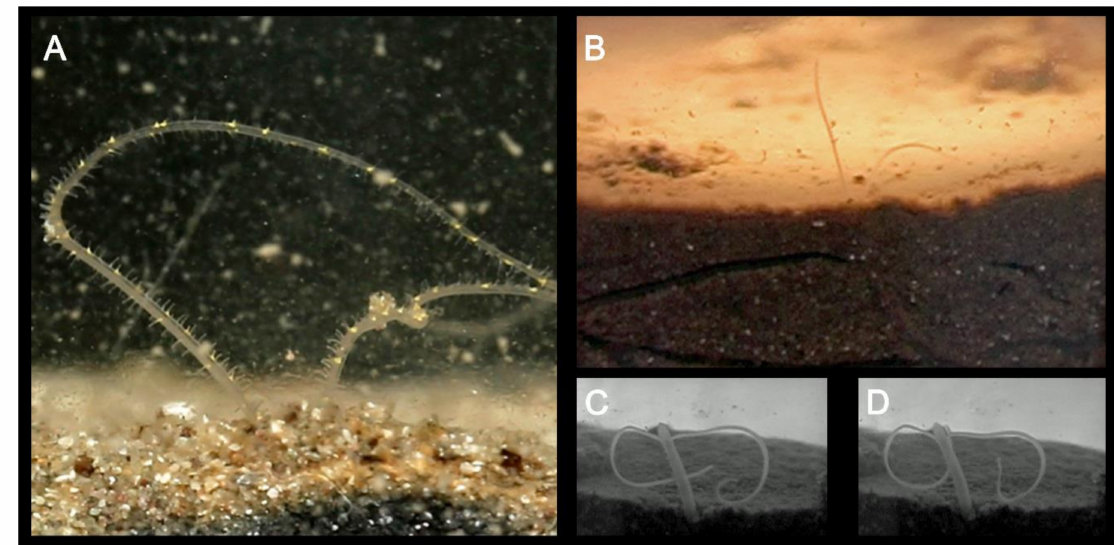
Figure 10. ( A ) Distal portion of the palps of Magelona alleni within the water column collecting food particles. Particles are transferred to the mouth via cooperative movements of the palp papillae (from [52]); ( B ) distal portion of the palps of M. johnstoni above the sediment surface. Animal can be seen in the burrow below, as well other burrowing tracks made by another individual; ( C , D ) anterior of an individual M. johnstoni protruding into the water column prior to initiation of lateral sinuous movements thought to be linked to